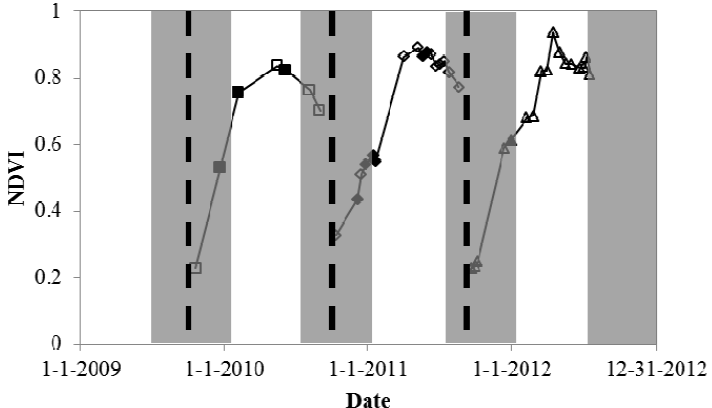
Figure 2. Example of the NDVI time profile of a southern sugarcane field for three consecutive years. Shaded areas represent the harvest period. Bold dashed black lines represent the harvest dates. Open symbols represent the SPOT-4 images, and solid symbols represent the SPOT-5